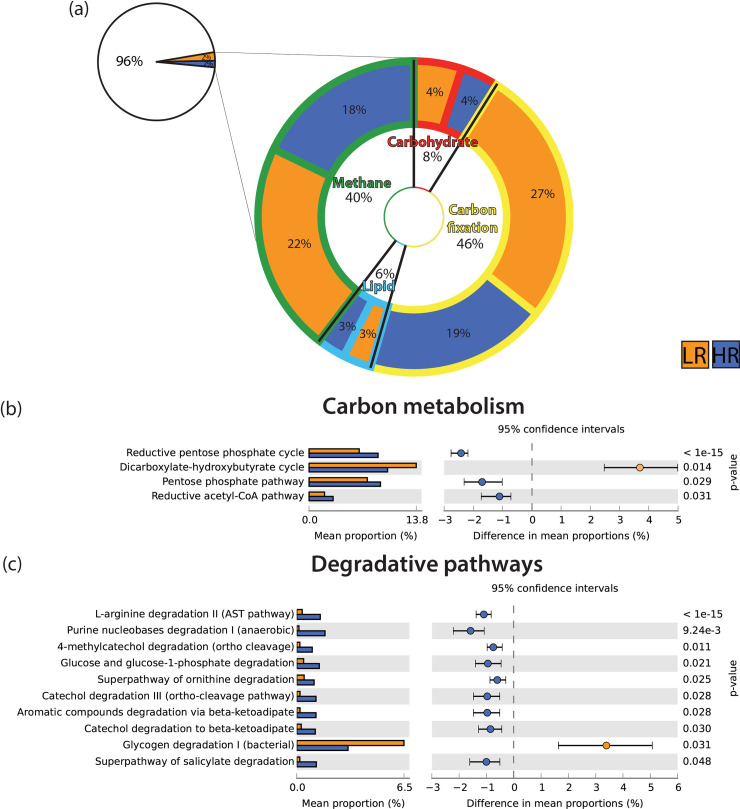
Prediction of the microbial community metabolic status based on 16S rRNA amplicon sequencing and functional genomics analyses between LR and HR periods from the bore W4.(a) doughnut chart showing the proportion of the metabolisms considered compared with the total pathways detected and the specific proportions of methane (green), carbohydrates (red), lipid (light blue and carbon fixation (yellow) metabolisms (derived from KOs). (b) and (c) extended error bar plots of predictive metagenome pathways differentially abundant between rainfall periods (P < 0.05, White’s non parametric t-test).